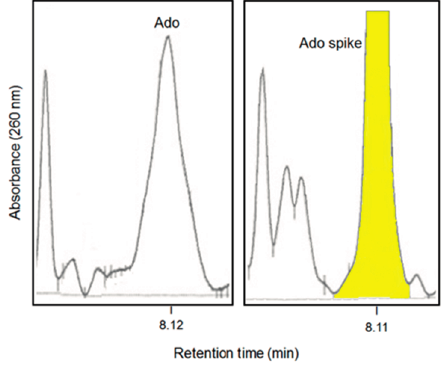
Figure 3. HPLC analysis of ADO (adenosine) content in BM (bone marrow) plasma aspirates from myeloma patients. In yellow is the ADO spiking.